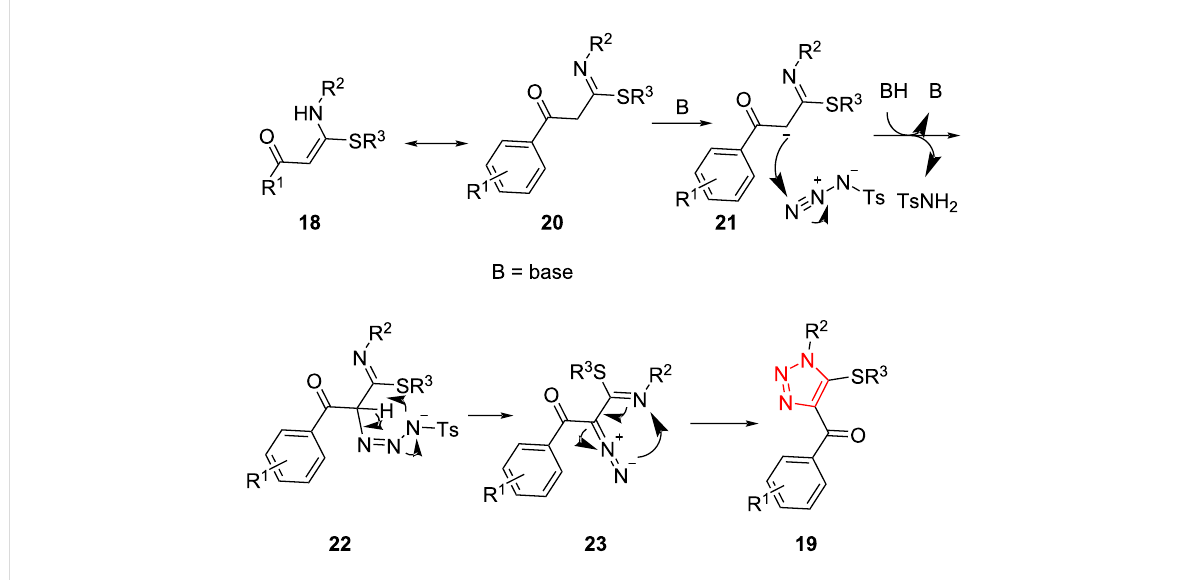
Scheme 9: Mechanism for the formation of fully decorated 1,2,3-triazoles 19 containing a sulfur-based side chain.